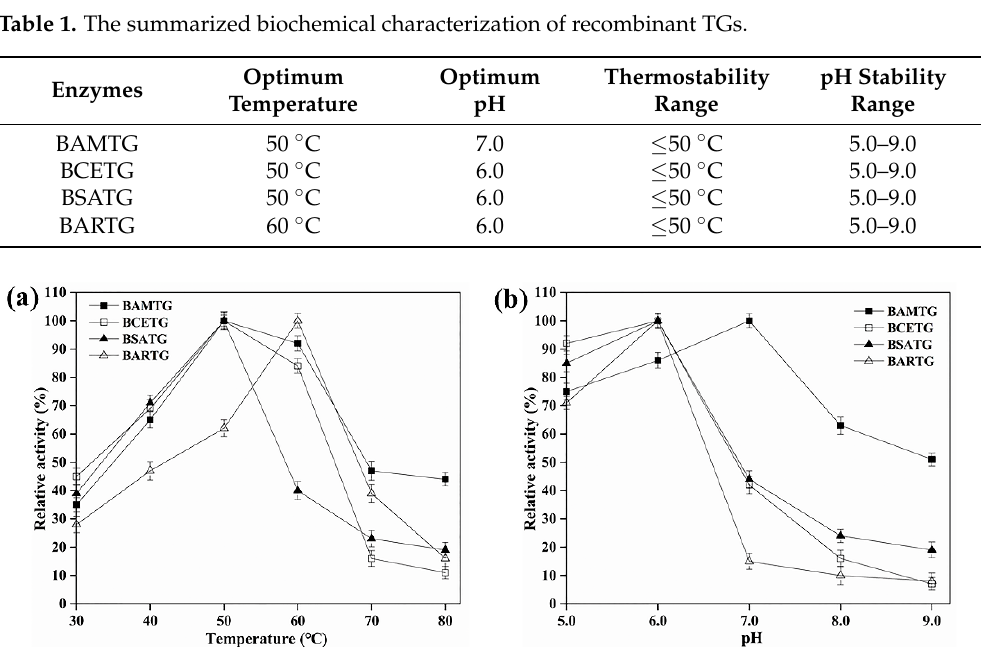
Figure 1. The optimum temperature and pH of recombinant TGs. ( a ) The influence of temperature on the BAMTG, BCETG, BSATG, and BARTG activities; ( b ) The influence of pH (5.0–9.0) on the activities of BAMTG, BCETG, BSATG, and BARTG. Three independent experiments were performed to calculate the values described by means ± SD.